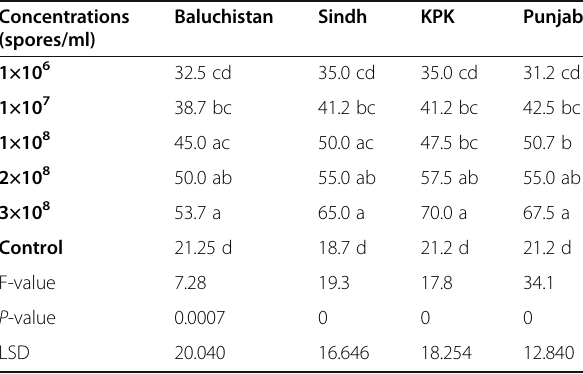
Table 3 Percent mortalities of Rhynchophorus ferrugineus on the 5th day after treatment with Beauveria bassiana Concentrations (spores/ml)